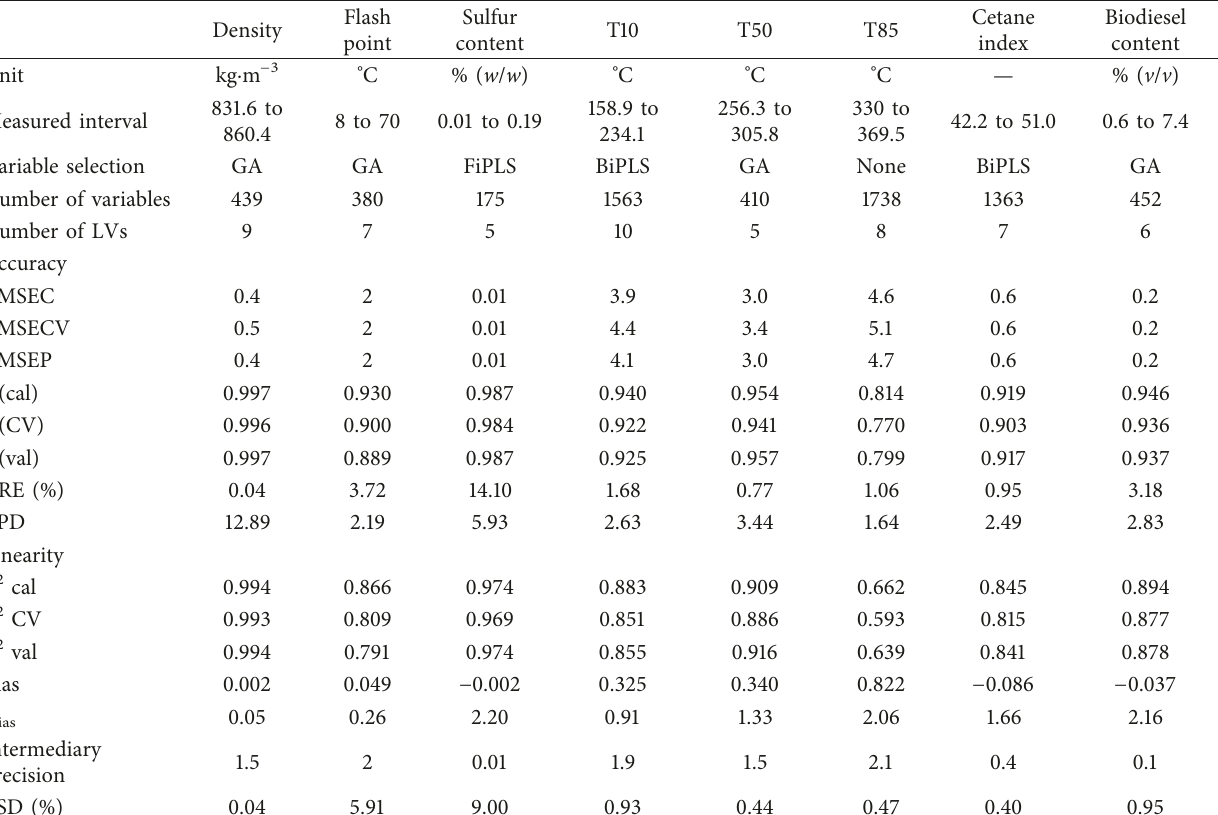
Table 7: Validation results of prediction models for quality parameters of